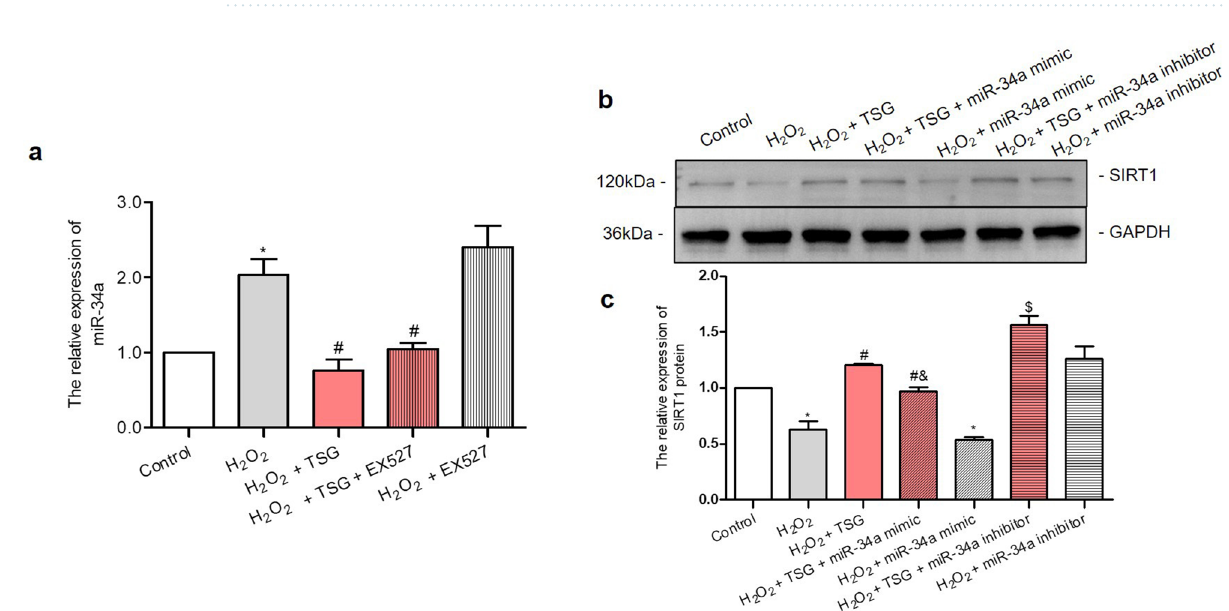
Figure 3. TSG down-regulated miR-34a resulting the activation of SIRT1. To study the mediating role of miR-34a in the regulation of SIRT1 by TSG, EX527 was used to inhibit SIRT1, and miR-34a mimic or inhibitor were used to interfere with miR-34a. ( a ) The effect of TSG pretreatment on miR-34a expression after SIRT1 inhibition by EX527 in H 2 O 2 - induced HUVECs. Except for the control group, all cell groups were treated with H 2 O 2 . Before H 2 O 2 induction, HUVECs were pretreated with TSG, EX527 or TSG + EX527 respectively for 24 h, the expression level of miR-34a was determined by qRT-PCR. ( b, c ) The effect of TSG pretreatment on SIRT1 expression after miR-34a over-expression or suppression. HUVECs were transfected with miR-34a mimic or miR-34a inhibitor for 24 h, then treated with TSG for 24 h, and finally induced by H 2 O 2 , the expression level of SIRT1 was determined by Western Blot. GAPDH was used as an endogenous control for SIRT1 expression. All groups of cells were treated with H 2 O 2 before administrations expect control group. Uncropped gel images are provided in the supplementary information. * p < 0.05 vs. control, # p < 0.05 vs. H 2 O 2 group, $ p < 0.05